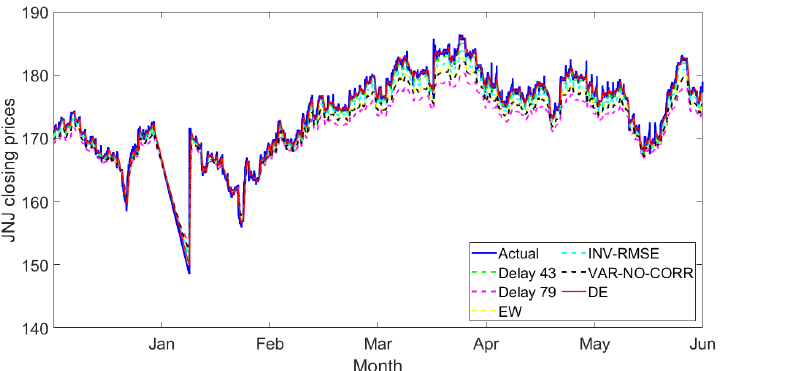
Figure 17. The forecasting curve for actual data versus the individual and combination methods of JNJ stock obtained from LSTM model between January and June 2022.